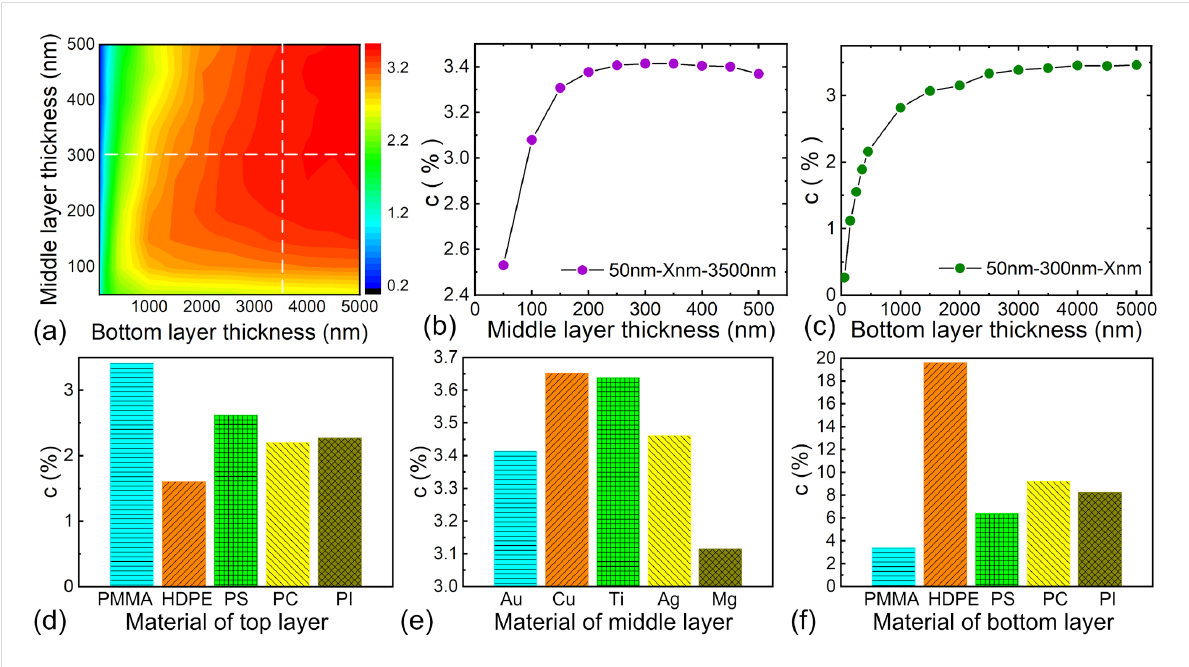
Figure 7: Influence of thickness and material properties of each layer on subsurface imaging of the circuit pattern. (a) Theoretical stiffness contrasts for different middle layer and bottom layer thicknesses. The theoretical calculations were made on the PMMA–Au–PMMA structures with a top layer thickness of 50 nm under a normal force of 100 nN. (b,c) Cross-section profiles at the middle layer thickness of 300 nm and the bottom layer thick- ness of 3500 nm, respectively. (d–f) Calculated contact stiffness contrasts when different materials are used for the top, middle and bottom layers. The thicknesses are 50, 300 and 3500 nm for the top, middle and bottom layers,